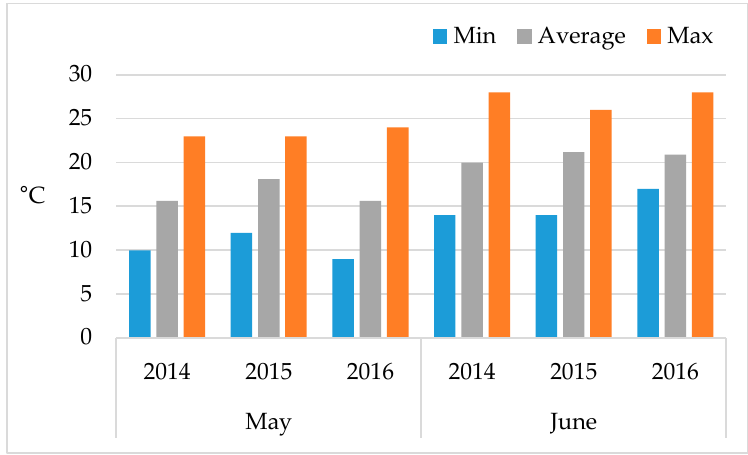
Figure 2. Mean daily temperatures in May and June during three consecutive years.